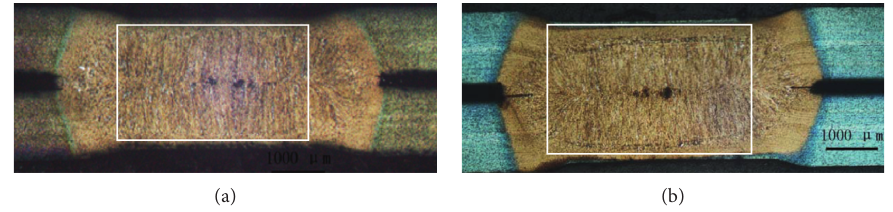
Figure 4: Cutting range. (a) QP980 steel RSW; (b) TRIP800 steel